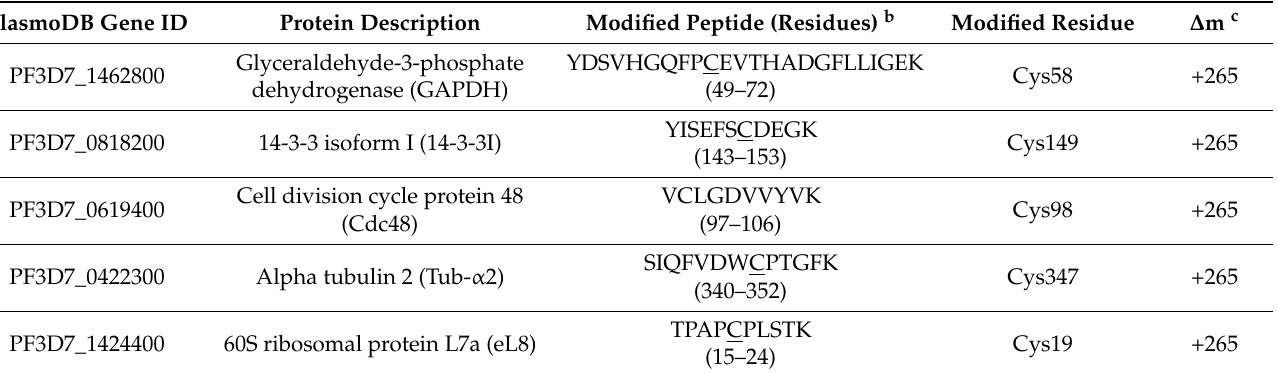
Table 2. P. falciparum gametocyte proteins with 1 adducts detected in at least 2 out of 3 biological replicates a